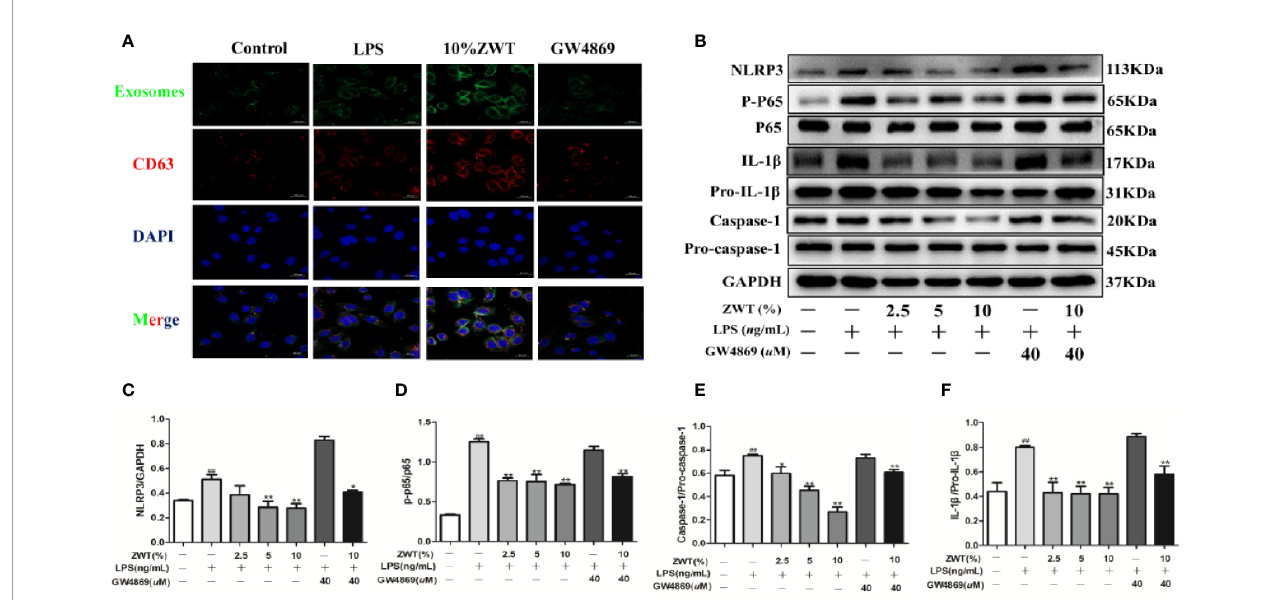
FIGURE 5 | HK-2-derived exosomes were absorbed by HMC. (A) DiO-labeled HK-2 cells were cocultured with recipient cells of HMC using a transwell system for 24 h. (B – F) After being cocultured HK-2 cells and HMC, western blot was conducted to detect the expressions of NLRP3, p-p65, p65, caspase-1, pro – caspase-1, IL-1 b and pro – IL-1 b in the HMC. The statistical data of all the proteins were analyzed and transformed by ImageJ 1.8.0 112 software. The obtained values of p-p65 were normalized to p65, caspase-1 were normalized to pro – caspase-1 and IL-1 b were normalized to pro – IL-1 b . (n = 3). All values were presented as mean ± SD. # P < 0.05, ## P < 0.01, compared with control group; *P < 0.05, **P < 0.01, compared with LPS